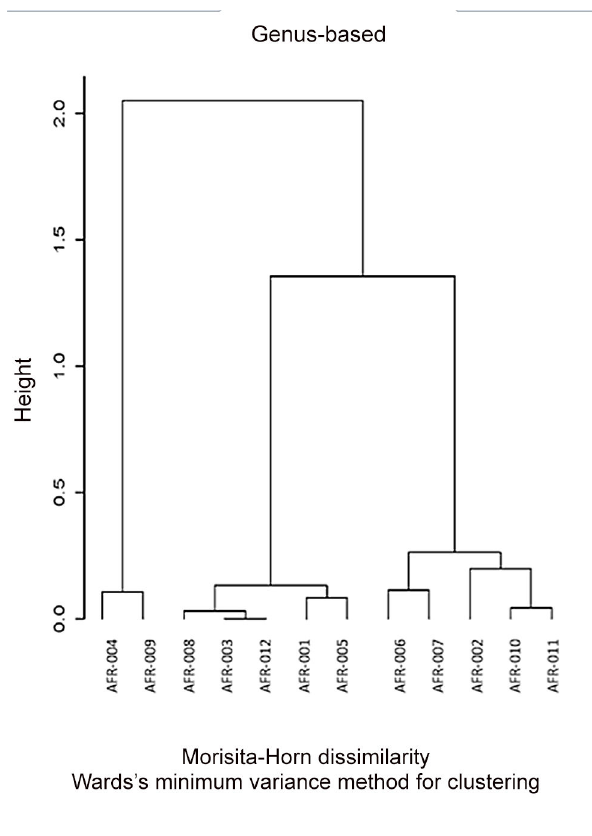
Figure 5. Dendrogram reflecting the healthy (AFR001-006) and colon polyps (AFR007-012) samples clustering based on the 454 pyrosequencing data analyzed at the genus